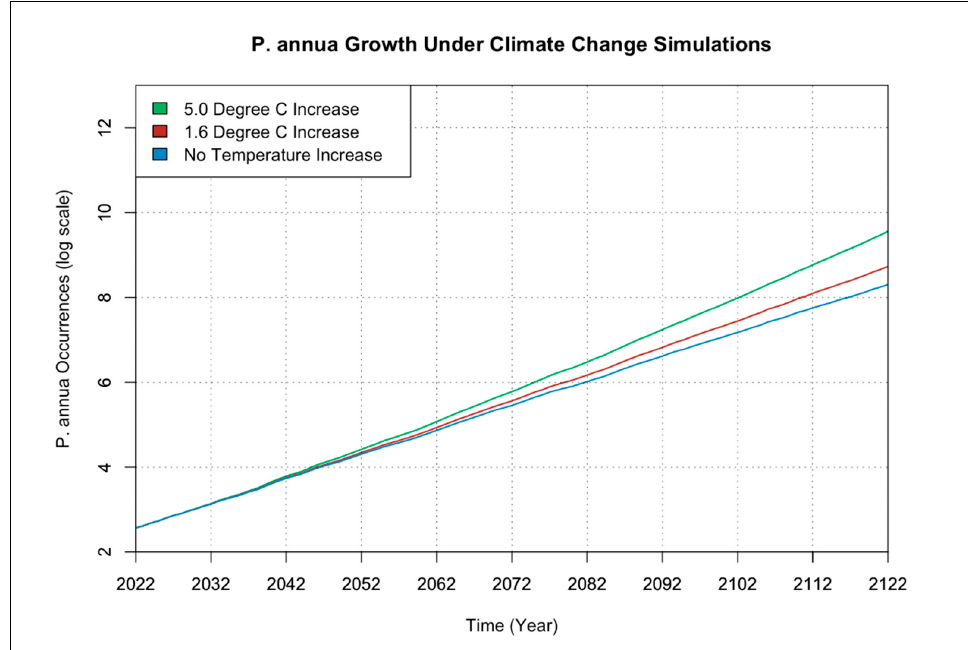
Figure 6. P. annua Occurrences Under No Temperature Increase, 1.6 °C Temperature Increase and 5.0 °C Temperature Increase Simulations (2022–2122). 5.0 ◦ C Temperature Increase Simulations